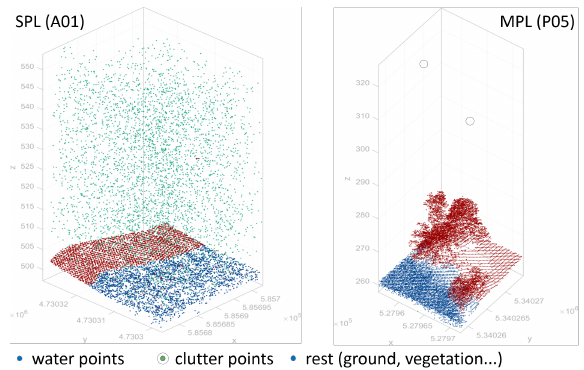
Figure 3. Perspective views of 3D point clouds; Single Photon LiDAR (left) and Multi-Photon LiDAR (right).